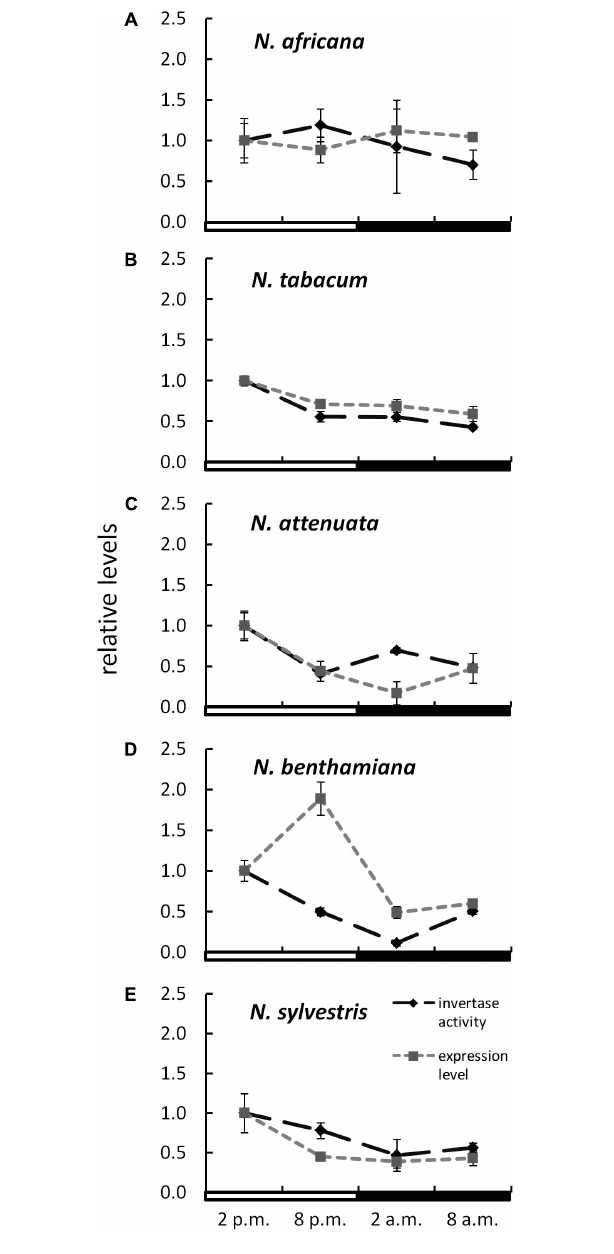
FIGURE 6 | Invertase activity in comparison to expression level in the nectaries of different Nicotiana species Activity and expression levels are given relative to the calibrator (2 p.m.). Mean values from all measurements taken at one time point ( n = 6 for enzyme activity and n = 3 for expression levels) and the respective SD were plotted; light and dark periods are indicated by white and black bars. (A) N. africana , (B) N. tabacum , (C) N. attenuata , (D) N. benthamiana , and (E) N. sylvestris